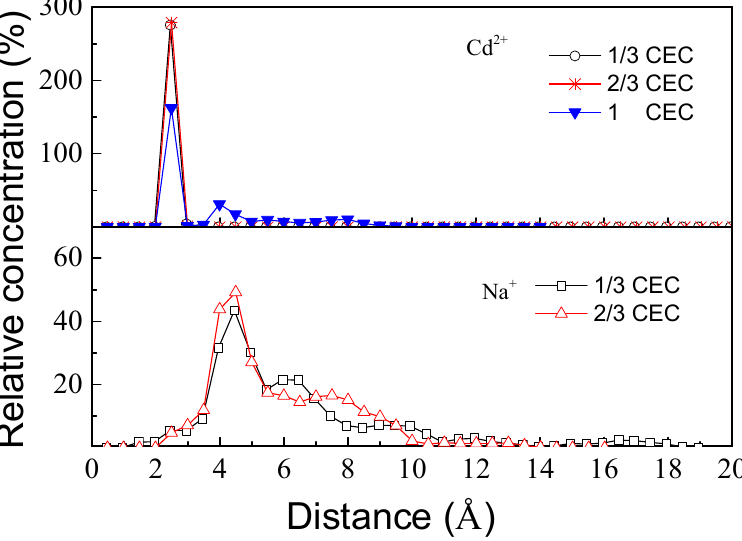
Figure 6. Relative concentration of cations at the interface.